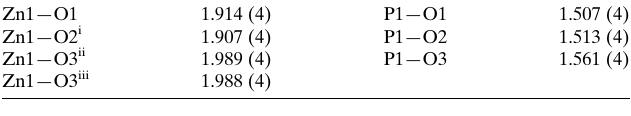
Table 3 Experimental details.